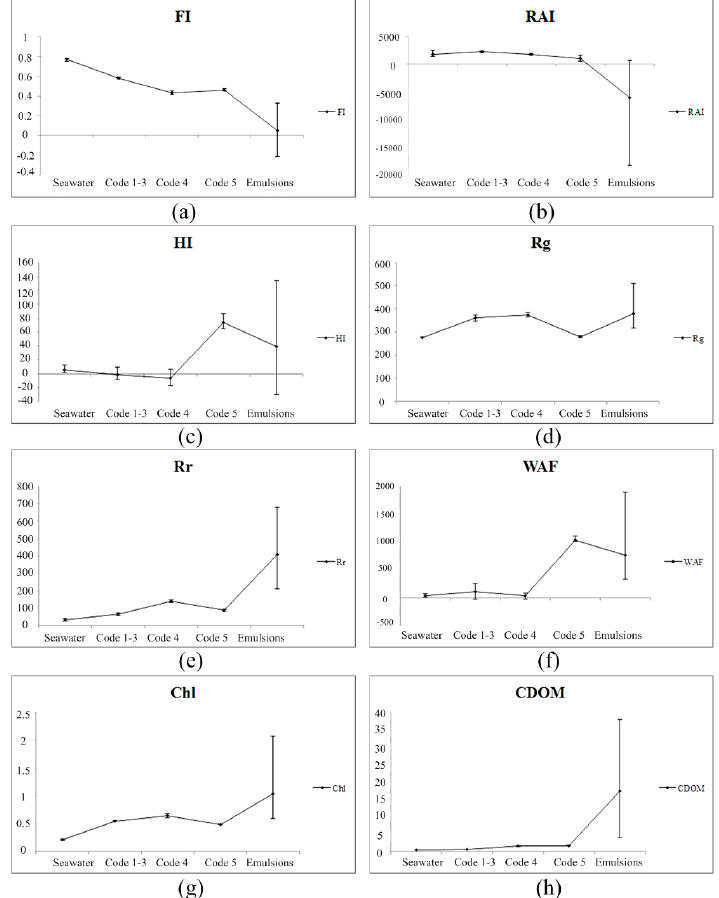
Figure 7. Differential line graphs of spectral indices of hydrocarbons and seawater are summed from the training results. Pictures ( a – h ) are differential line graphs of FI, RAI, HI, Rg, Rr, WAF, Chl, and CDOM, respectively.